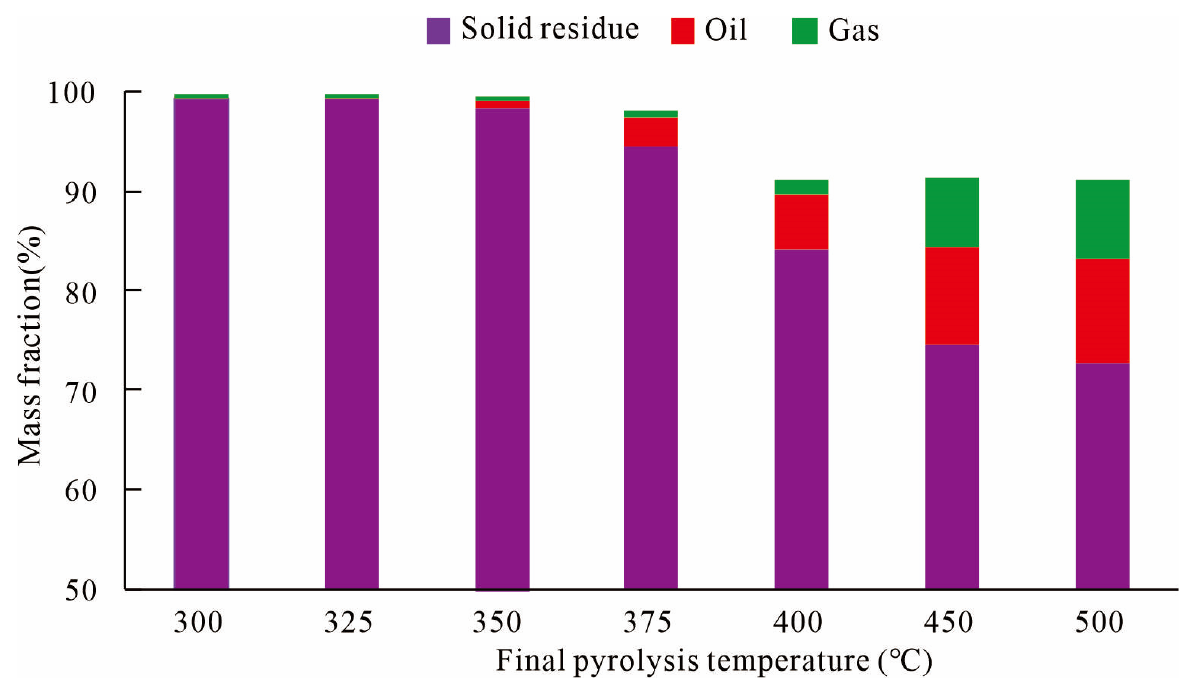
Figure 4. Evolution of mass fractions with pyrolysis temperature.